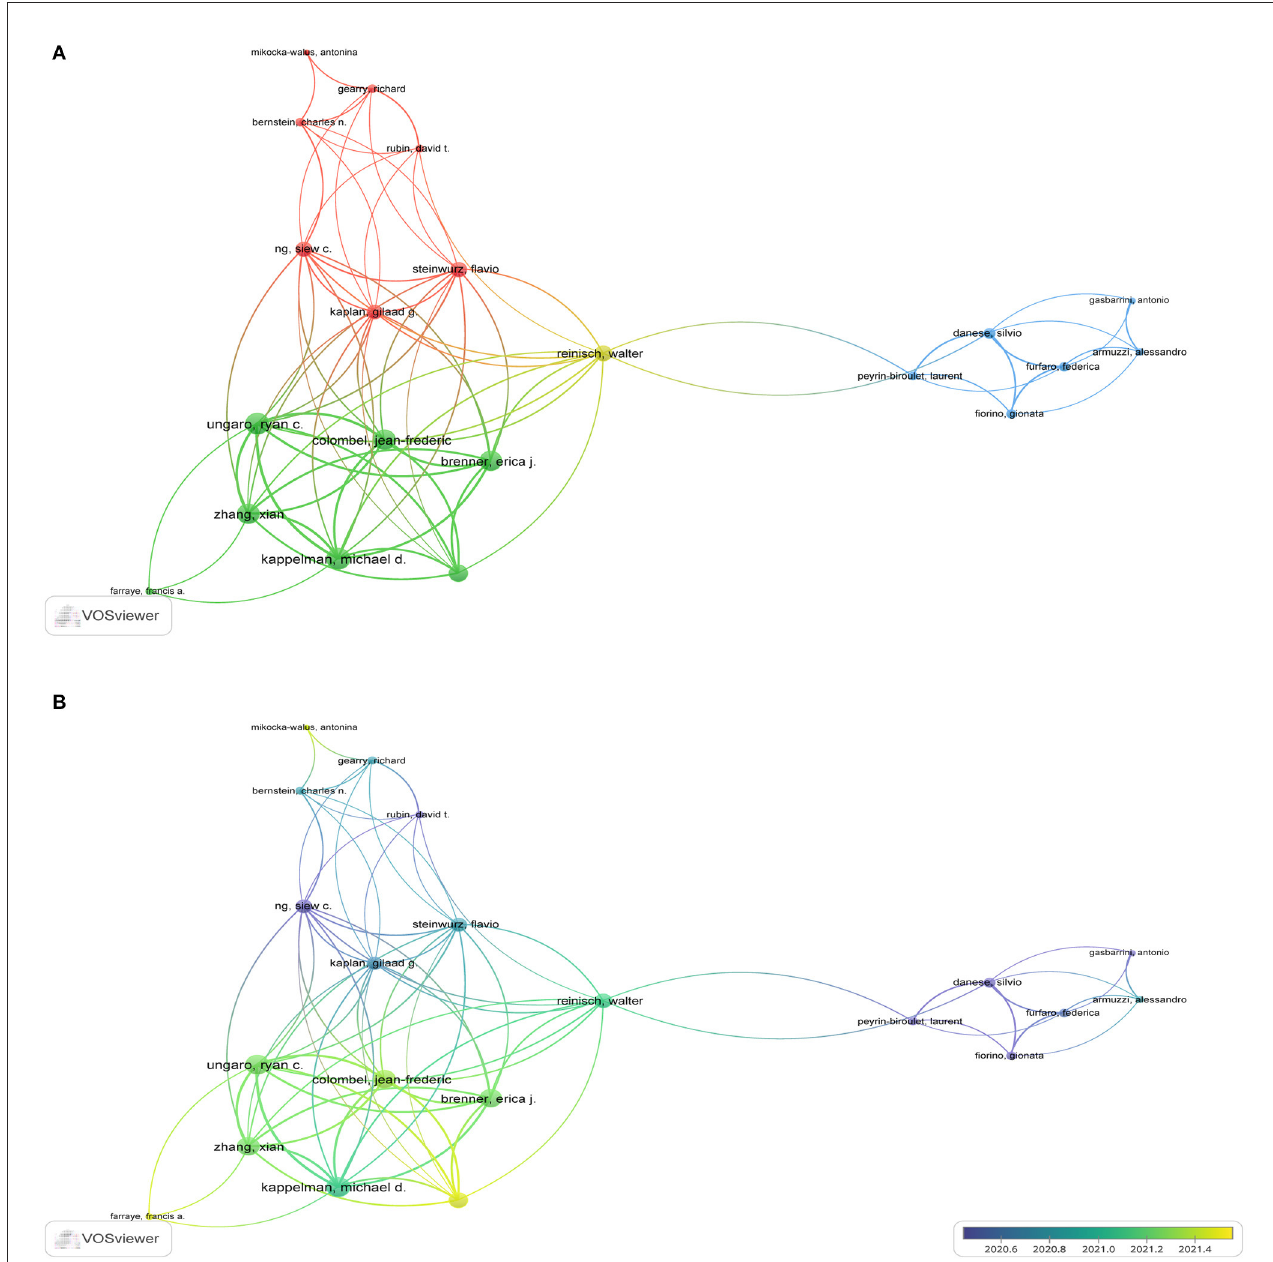
FIGURE3 The analysis of co-authors in the field of IBD and COVID-19. (A) The top 21 most co-authors. (B) Time sequence chart of co-authors.